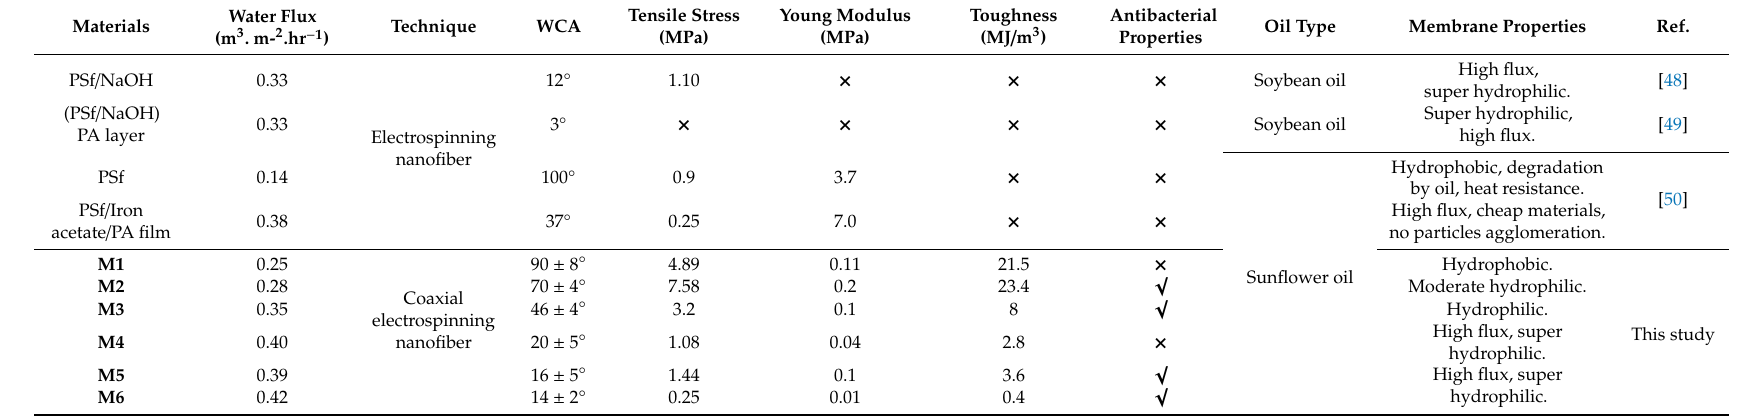
Table 2. Present membrane properties compared with reported membranes: membrane materials, water flux, technique, tensile stress, oil type, and membrane features.